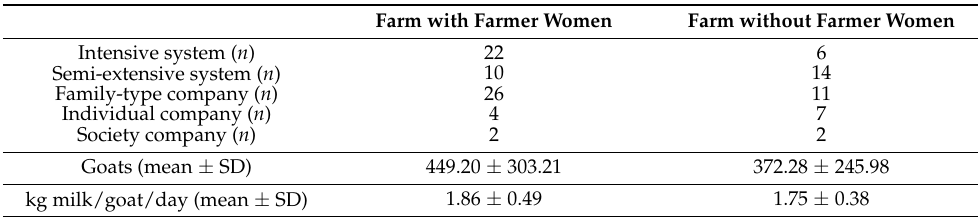
Table 1. Characteristics of farm with or without farmer women (mean ± SD).